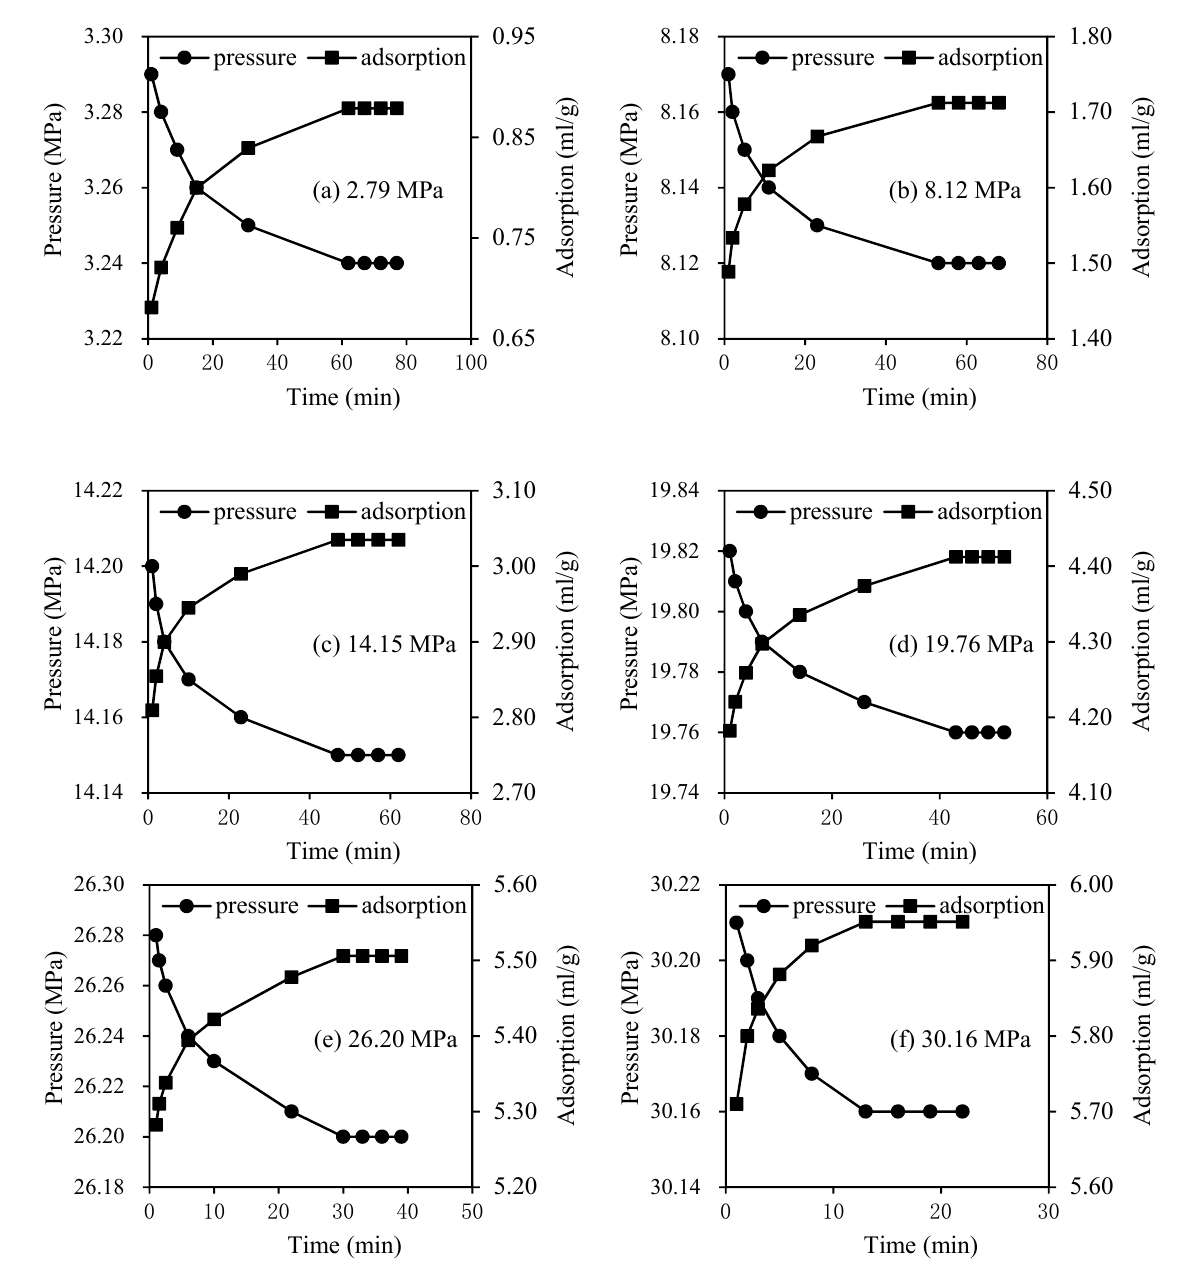
Figure 3. Methane adsorption dynamic on shale sample at six pressure steps and 40 °C.